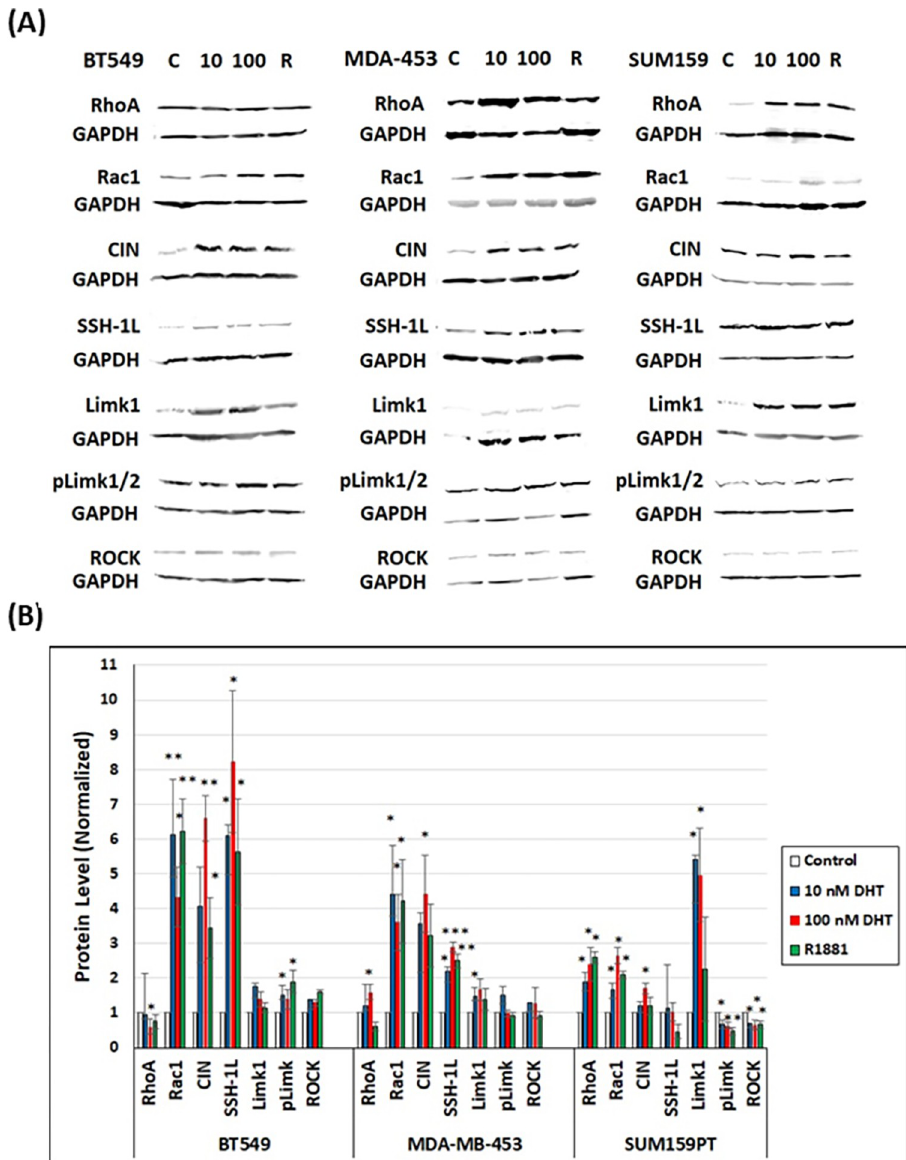
Fig 3. Androgen treatment changes protein levels of cofilin phosphatases in BT549 and MDA-MB-453 and LIMK1 in SUM159PT cells. (A) Representative western blots of lysates from vehicle- and androgen-treated TNBC cells immunolabeled with antibodies against different cofilin regulators. The experiment was repeated three times and the corresponding quantification is shown in (B). (B) Quantification of protein levels of different cofilin regulators (Total RhoA, total Rac1, chronophin (CIN), slingshot (SSH), total LIMK1 (LIMK1), pLIMK1/2, and ROCK) in androgen-treated cells as compared to control cells (set as 1.0 a.u.) obtained from densitometers of immunoblots. � p < 0.05, �� p < 0.01, ��� p < 0.001 versus